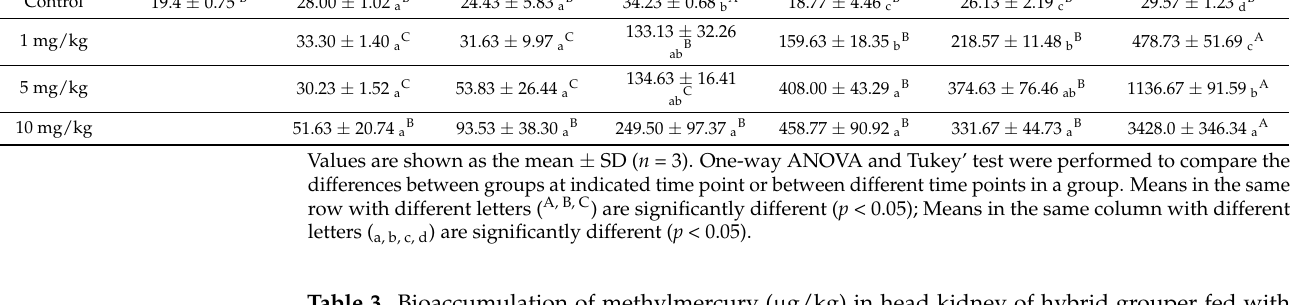
Table 3. Bioaccumulation of methylmercury ( µ g/kg) in head kidney of hybrid grouper fed with various concentrations of methylmercury for 28 days.